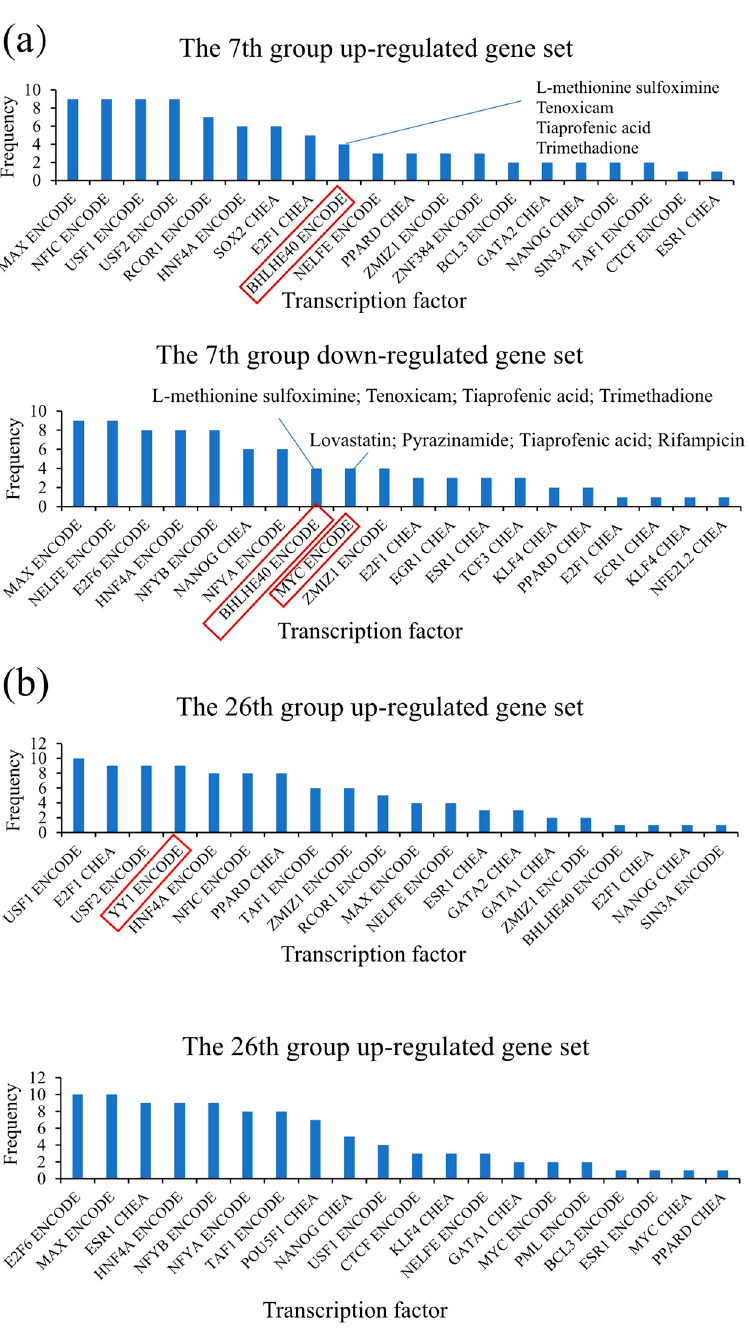
Figure 3. The TFs’ frequency of occurrence in groups 7 and 26. ( a ) The frequency of the top 20 enriched TFs of the up/down-regulated genes in the group 7. ( b ) The frequency of the top 20 enriched TFs of the up/down-regulated genes in the group 26.